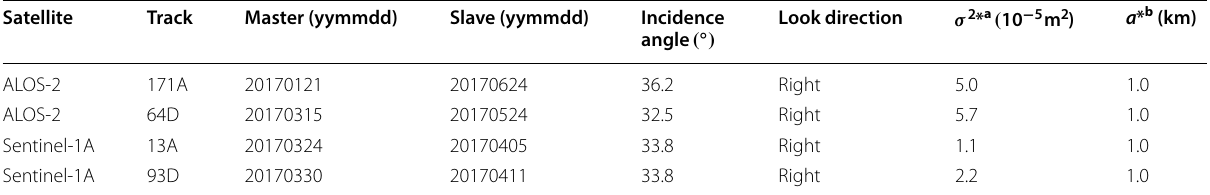
a and b Variance and correlation length, respectively, used in this study